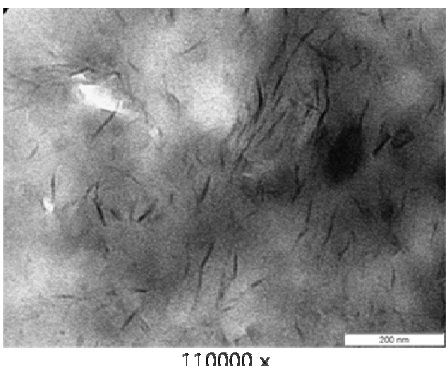
Figure 4. TEM photomicrographs for the film nanocomposite PA6/OMMT-Dod.